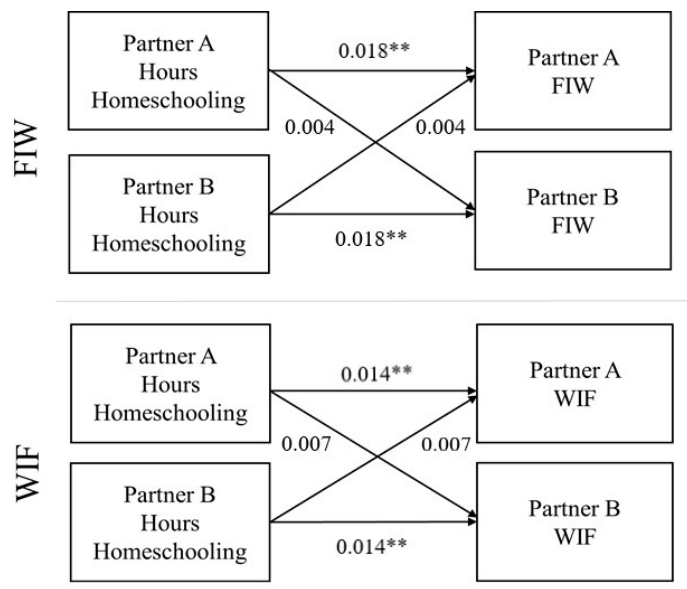
Figure 1. Actor–Partner Interdependence Models (APIMs; Indistinguishable Dyads) examining actor and partner effects of time spent homeschooling on family interference with work (FIW) and work interference with family (WIF). * p < 0.05; ** p < 0.01; *** p < 0.001. However, inconsistent with H6, partner time spent homeschooling was unrelated to one’s own work–family conflict—either for FIW conflicts or for WIF conflicts (Figure 1). Neither actor nor partner effects on either index of WFC were significantly moderated by gender, inconsistent with H5 (Table 4). The effect of partner age on WIF was significant ( p = 0.003). Table 4. Actor–Partner Interdependence Models (Distinguishable Dyads) Examining Partners’ Hours spent Homeschool- ing on Work Family Conflict and Alcohol Use and Interactions with Gender. Step